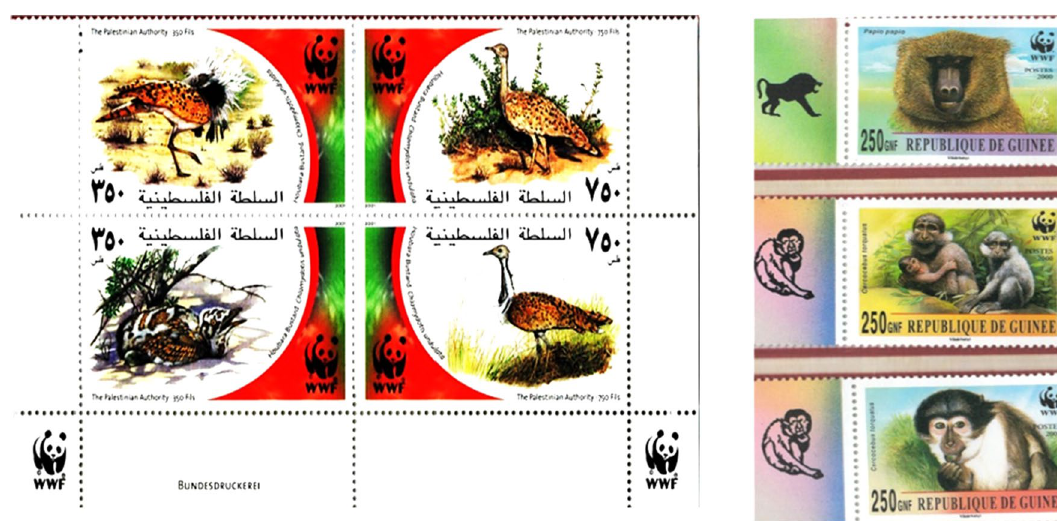
Fig. 5 Example SbRG stamps from WWF partnerships with countries attempting to save their indigenous